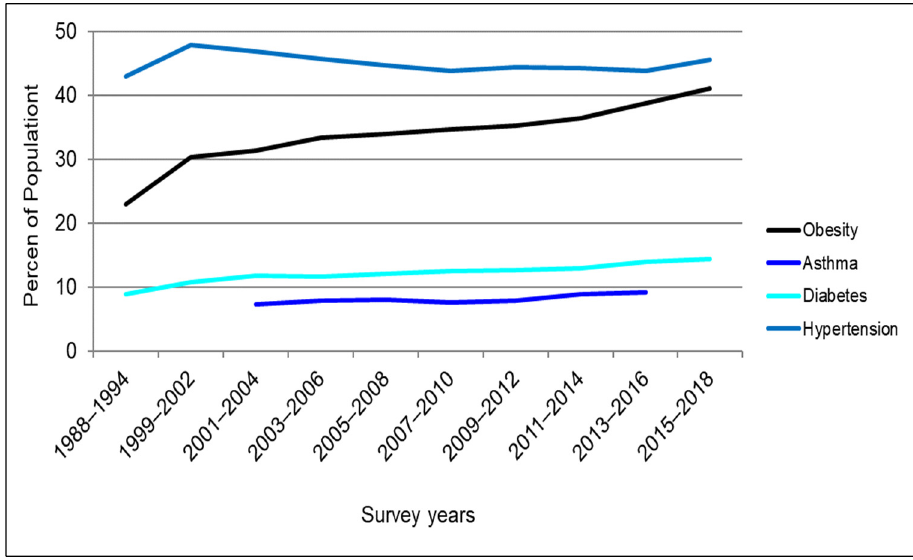
Figure 2. Trends in health conditions among U.S. adults. Source of data: [2–6].